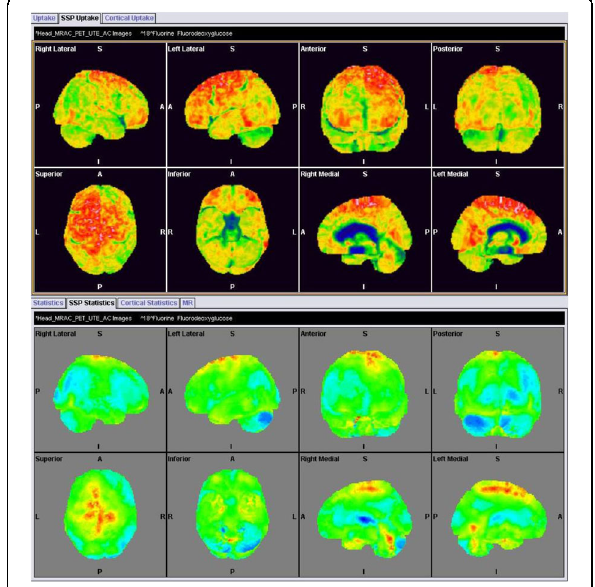
Fig. 3 (abstract P188). PET-MRI showing a right parieto-temporal and frontal hypo-metabolism; a bilateral hypo-metabolism of cingulate cortex is visible, as